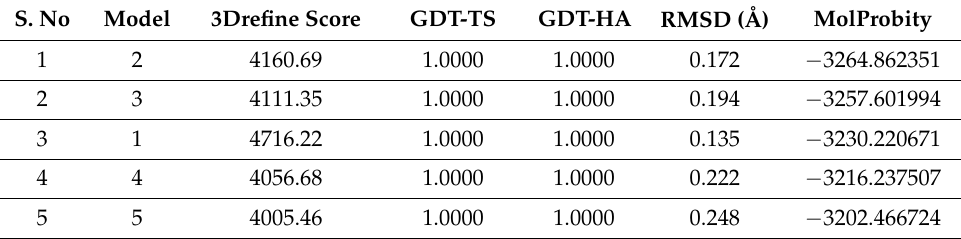
Table 1. Protein dynamics is simulated using a CABS coarse-grained protein model (CABS-flex) results of tau, top five protein molecular dynamics simulation data with global distance test (GDT-TS) values (calculated on the C α atoms), global distance test main-chain prediction (GDT-HA), along with corresponding root mean square deviation (RMSD) with MolProbity.